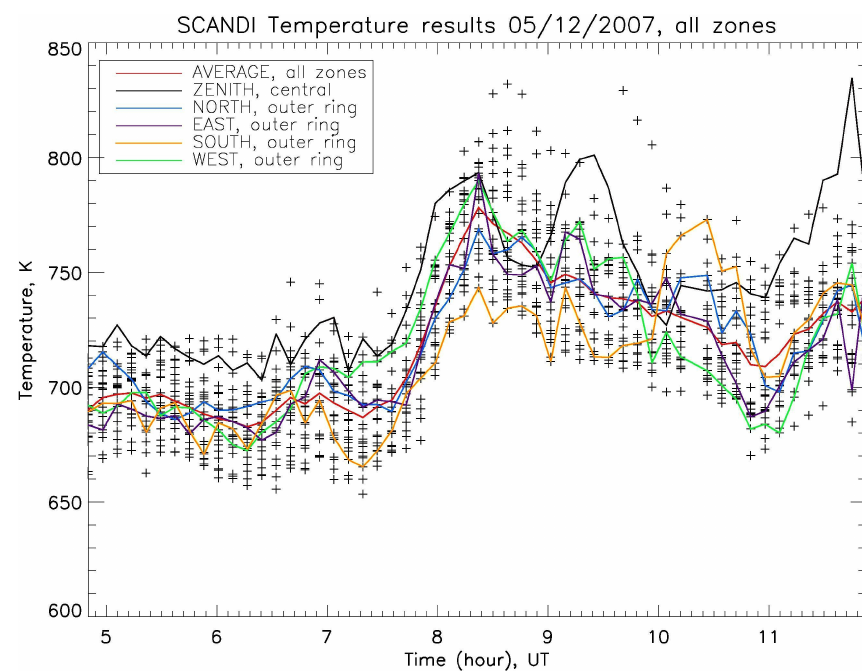
Fig. 5. Time dependence of the SCANDI neutral temperatures from all 25 zones for 05:00–12:00UT on 5 December 2007.